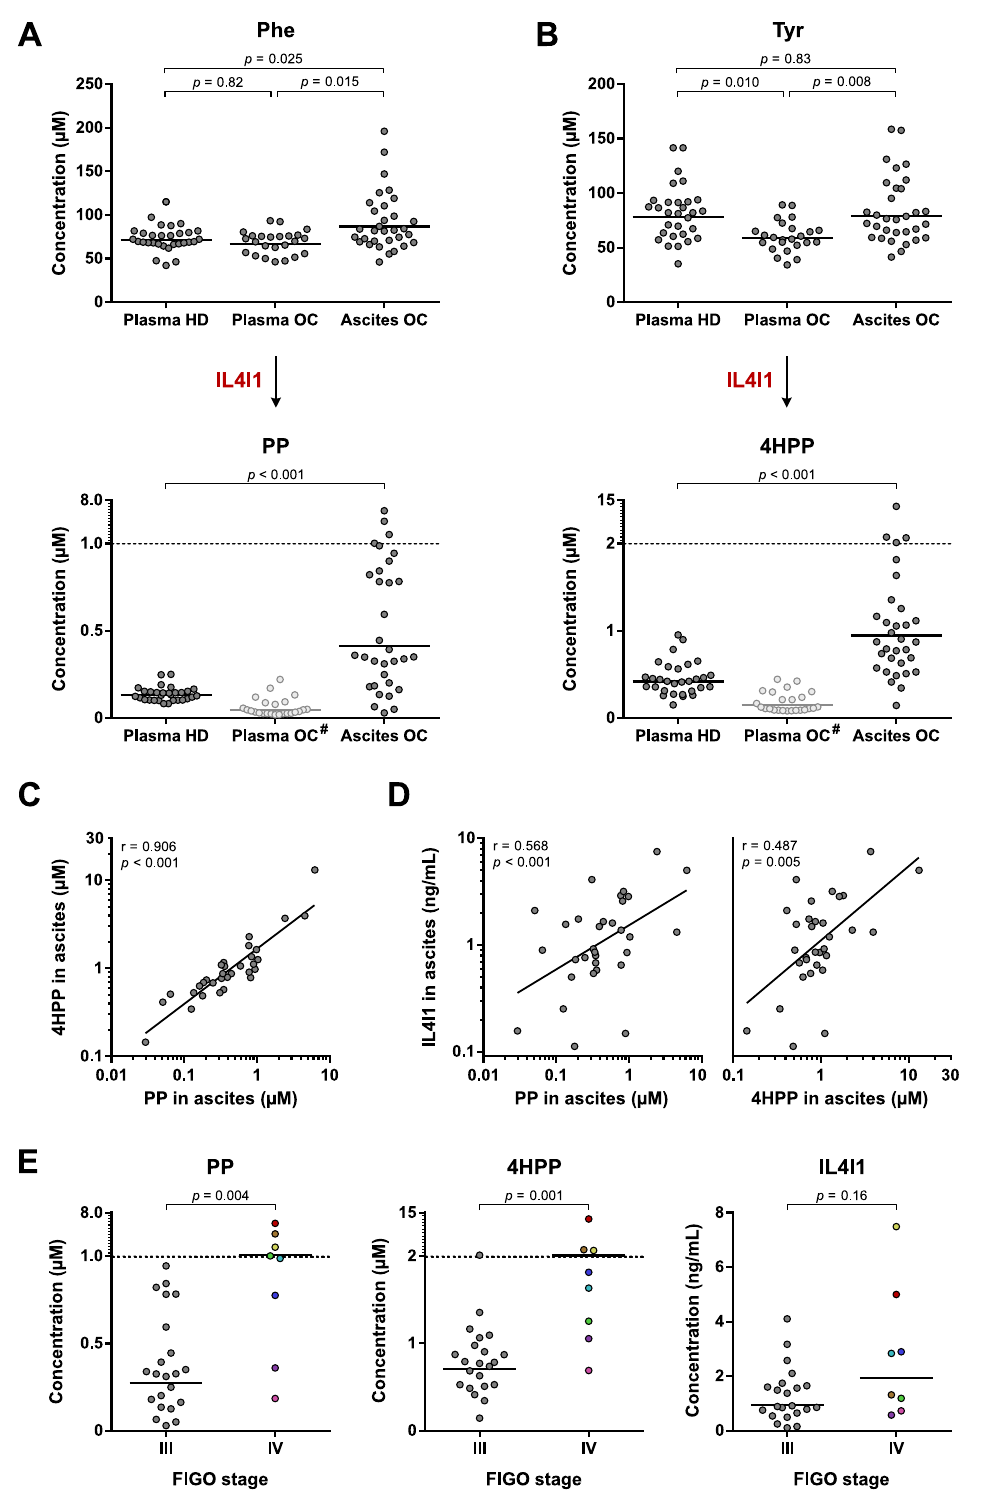
Figure 6. Phe and Tyr metabolism in high-grade serous ovarian cancer patients and healthy donors. Amino acid and metabolite levels corresponding to ( A ) Phe and ( B ) Tyr metabolism as indirect measures of IL4I1 enzymatic activity in plasma of healthy donors (HD) ( n = 30) and plasma and ascites of ovarian cancer patients (OC) ( n = 24 and 32, respectively, with n = 22 overlapping patients). Levels of Phe, Tyr, PP and 4HPP were determined by LC-MS/MS analysis. Horizontal lines indicate geometric means. Repeated unpaired, two-tailed Kruskal–Wallis tests yielded significant results